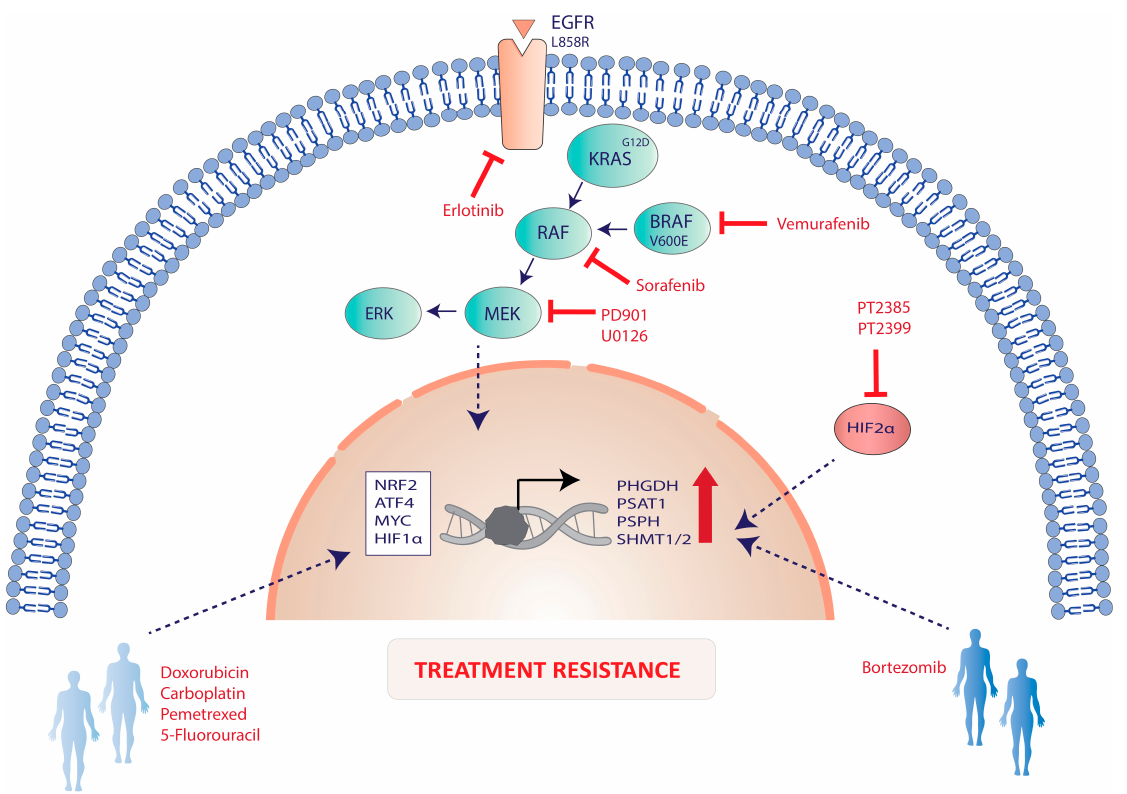
Figure 3. Serine/glycine biosynthesis pathway activation in tumor treatment resistance. The response to targeted therapies in tumors with abnormal activation of RAS–RAF–MEK–ERK pathway has been associated with increased expression of serine/glycine biosynthesis genes, which might be induced by oncogenic drivers such as EGFR L858R and KRAS G12D via ATF4 and NFR2, respectively. In addition, serine/glycine biosynthesis pathway hyperactivation has been linked to the resistance to chemotherapeutic drugs, e.g., doxorubicin, carboplatin, pemetrexed, or 5-fluorouracil in breast, lung, and colorectal cancer (CRC), the proteasome inhibitor bortezomib in multiple myeloma, as well as HIF2 α antagonists in renal cell